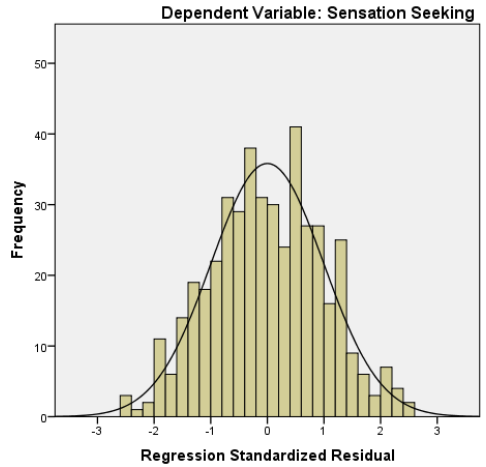
Figure 1. Normal Distribution